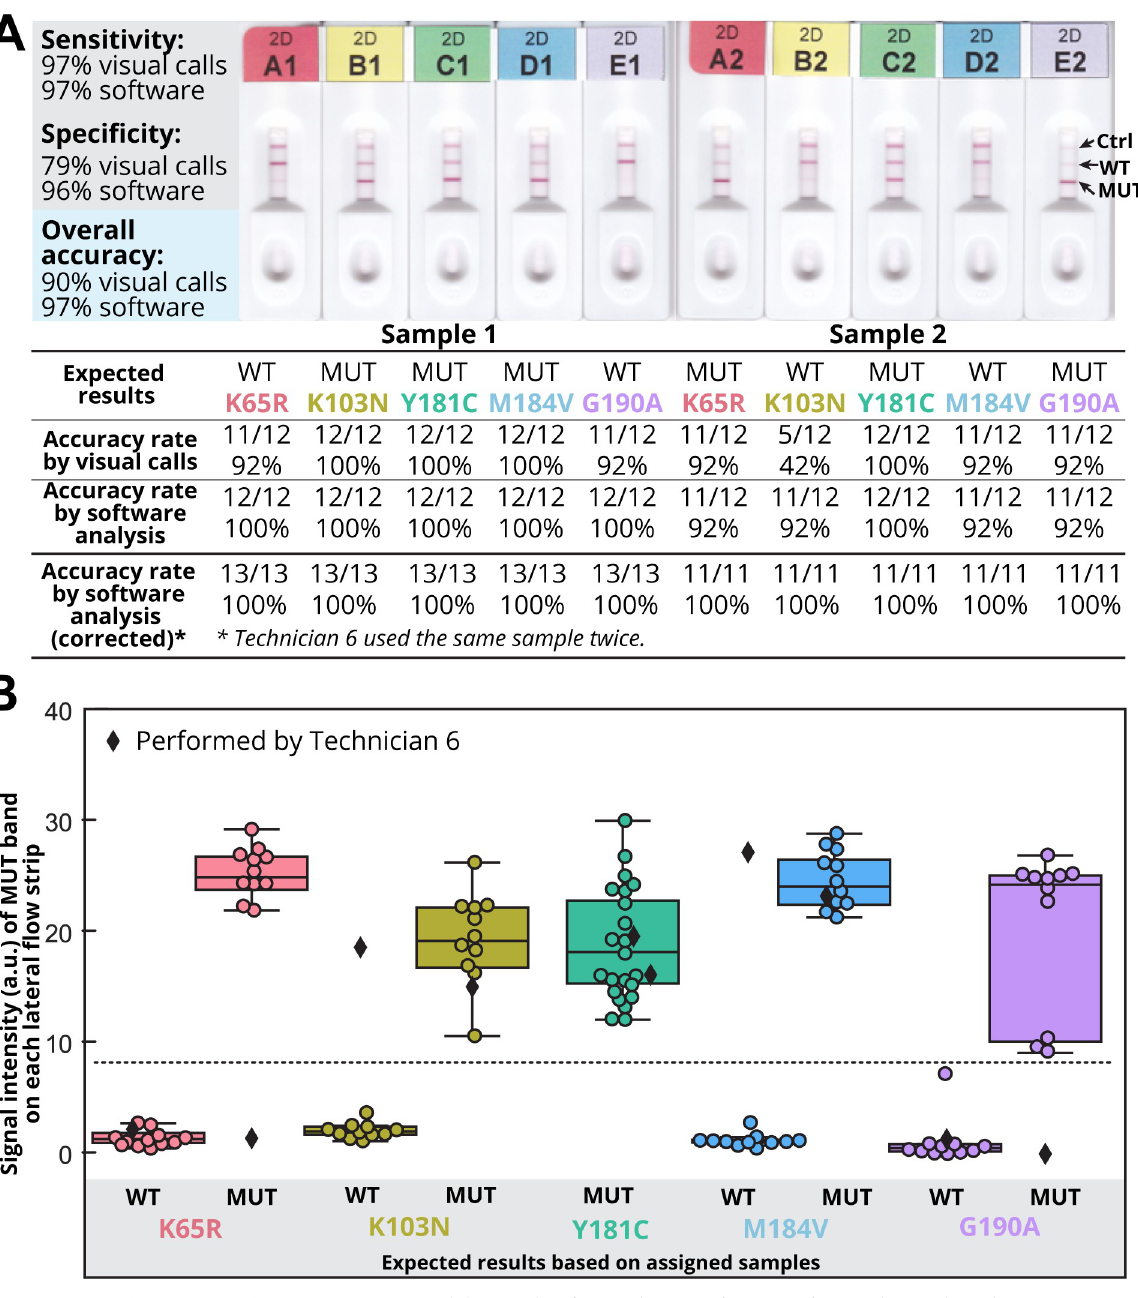
PLOS Global PublicHealth | https://doi.org/10.1371/journal.pgph.0000185 February 16,